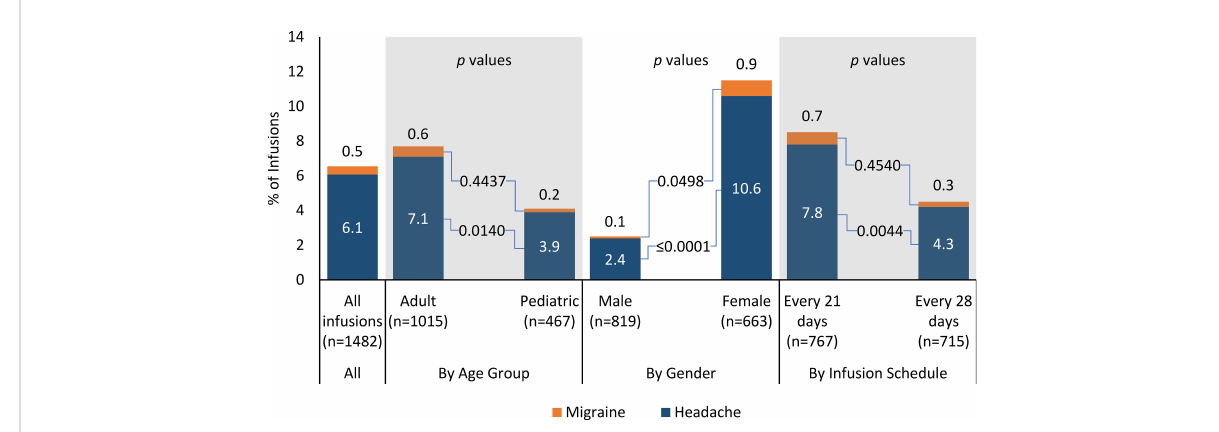
FIGURE 2 Percentage of infusions associated with product-related headache or migraine by